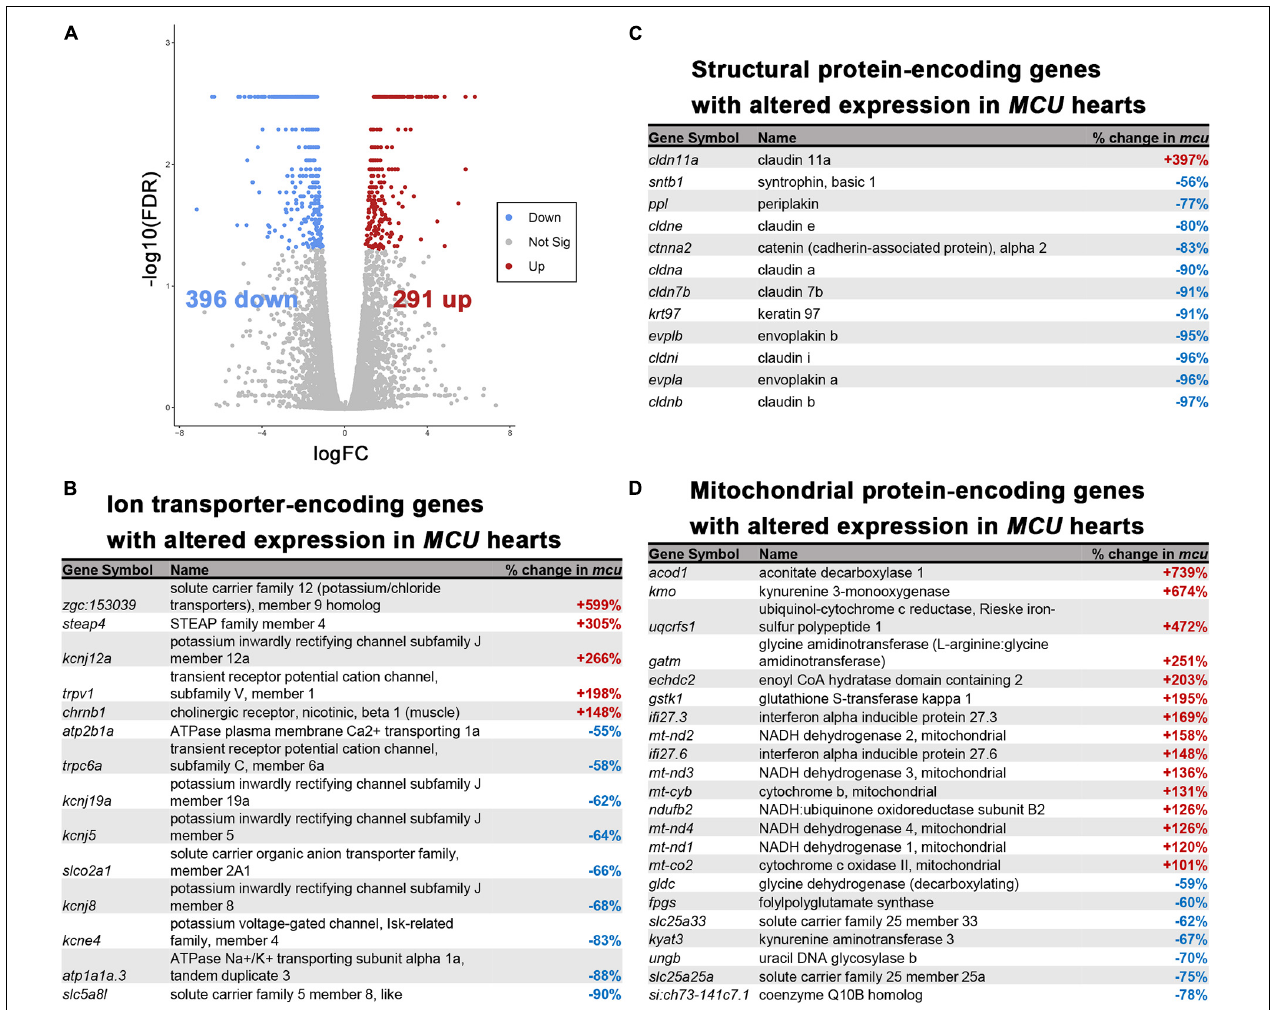
FIGURE 6 | RNA-seq analysis of the MCU mutant adult heart. (A) Volcano plot of differential gene expression of MCU mutant hearts vs. wildtype. Each point represents the average value of one transcript in duplicate experiments. The expression difference is considered significant for an adjusted p -value (FDR) of less than 0.05. Red points represent genes significantly upregulated in MCU mutants and blue points represent significantly down regulated genes. FDR, false-discovery rate. (B–D) Selected lists of significantly differentially expressed (FDR < 0.05) ion transporter-encoding (B) , structural protein-encoding (C) , and mitochondrial protein-encoding (D) genes. The percent increase (+, red) or decrease (-, blue) in expression in MCU compared to WT, based on the fold-changes determined by Cufflinks, is displayed in the right